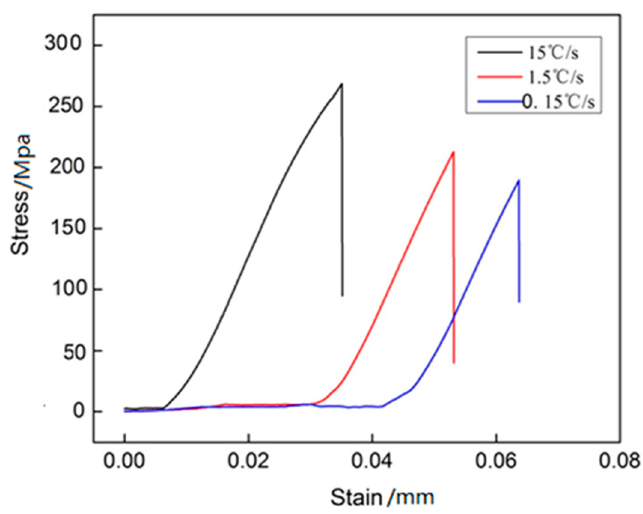
Figure 8. The stress strain curve of different cooling rate of the